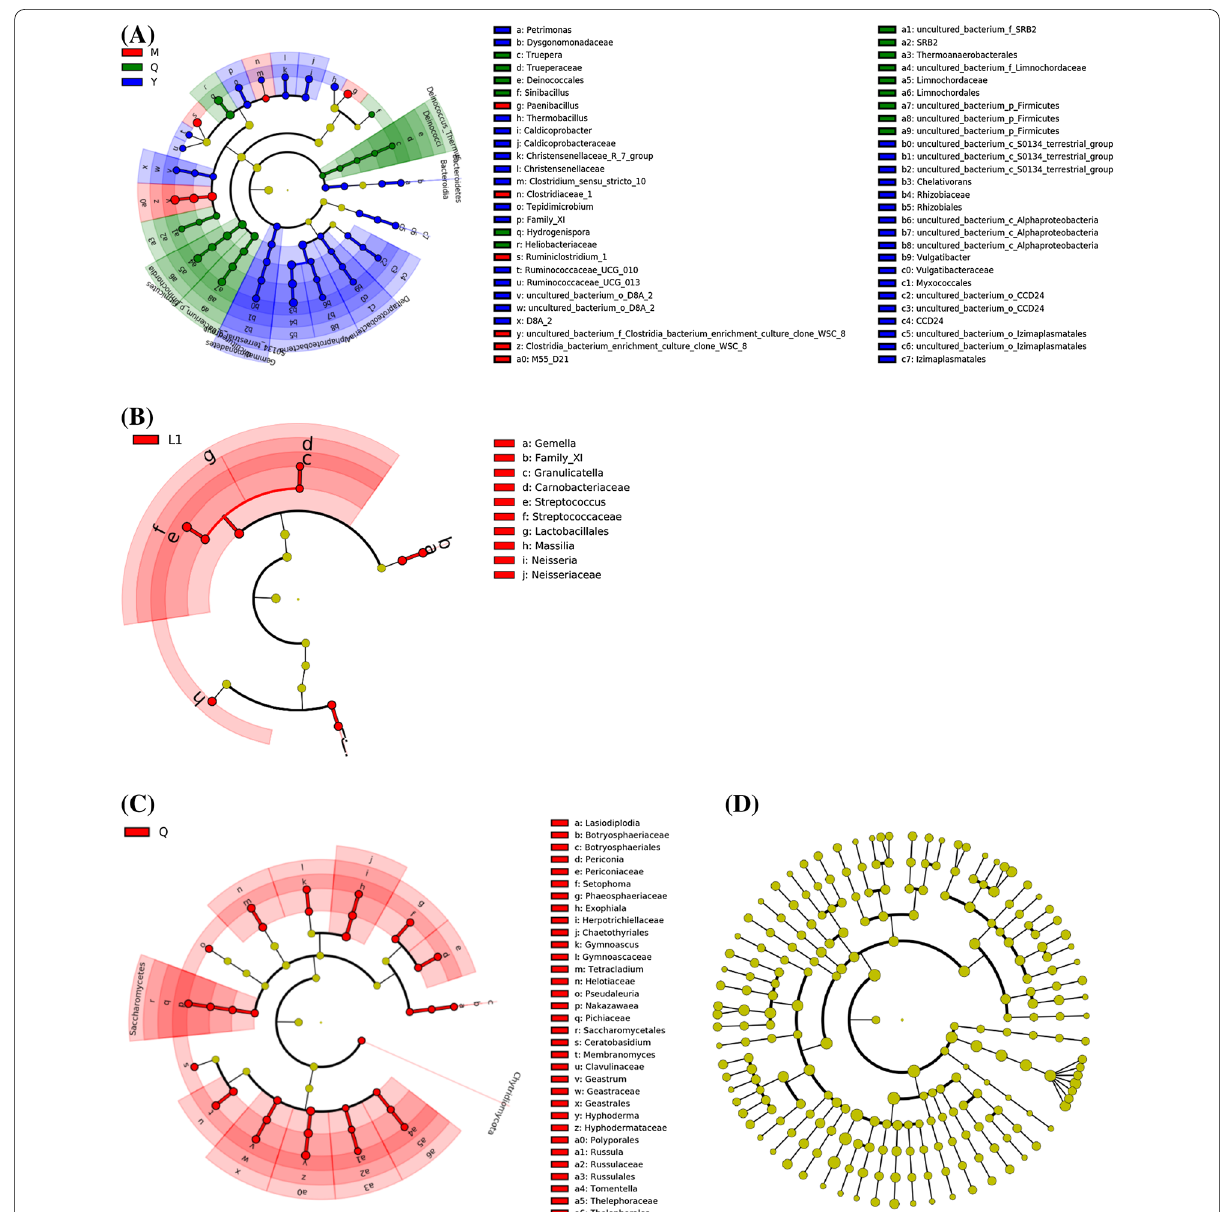
Fig. 5 LEfSe analysis of bacterial ( A , B ) and fungal ( C , D ) composition changes following different microflora sources ( A / C ) and liquid volumes ( B / D ) (LDA > 2). M, microbial consortia source from MC1; Q, microbial consortia source from MC1, sheep, and cattle feces; Y, microbial consortia source from sheep feces; L1, 100 mL PCS medium; L2, 200 mL PCS